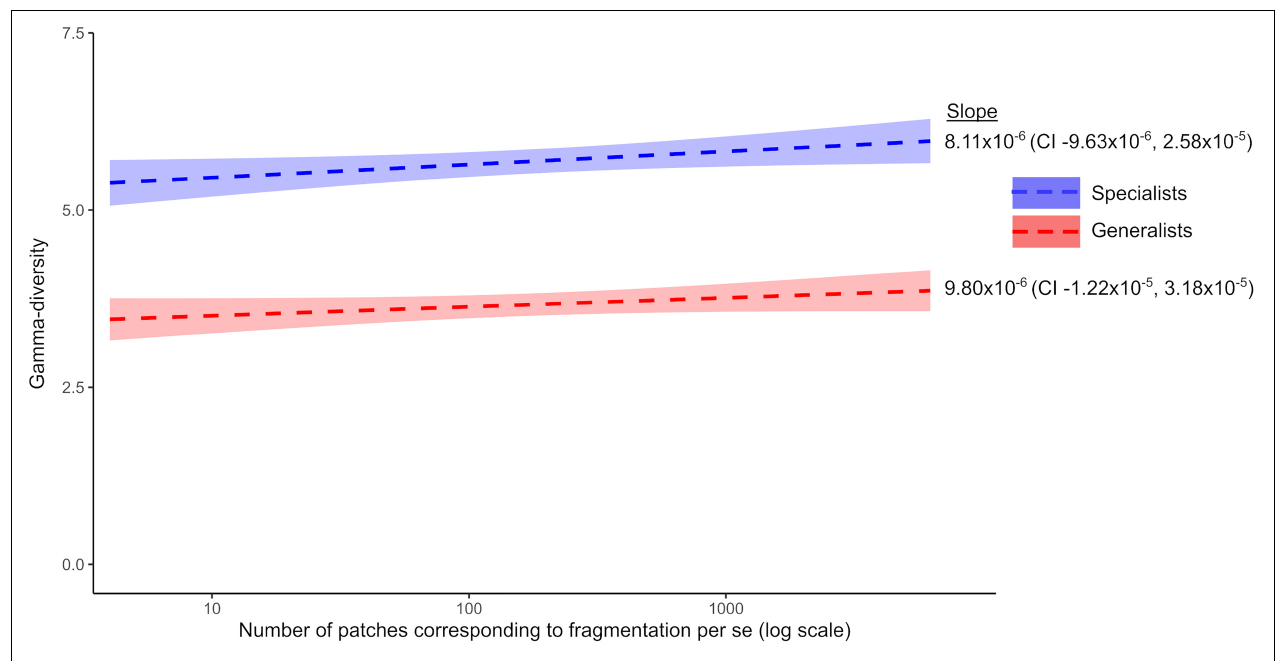
FIGURE 6 | Gamma-diversity for those species for whom the focal-habitat had high suitability for the specialization model (habitat bias and mortality slope 1 and 0.5, respectively) showing specialists and generalists separately. Gamma-diversity increases with FPS for both specialists and generalists in all